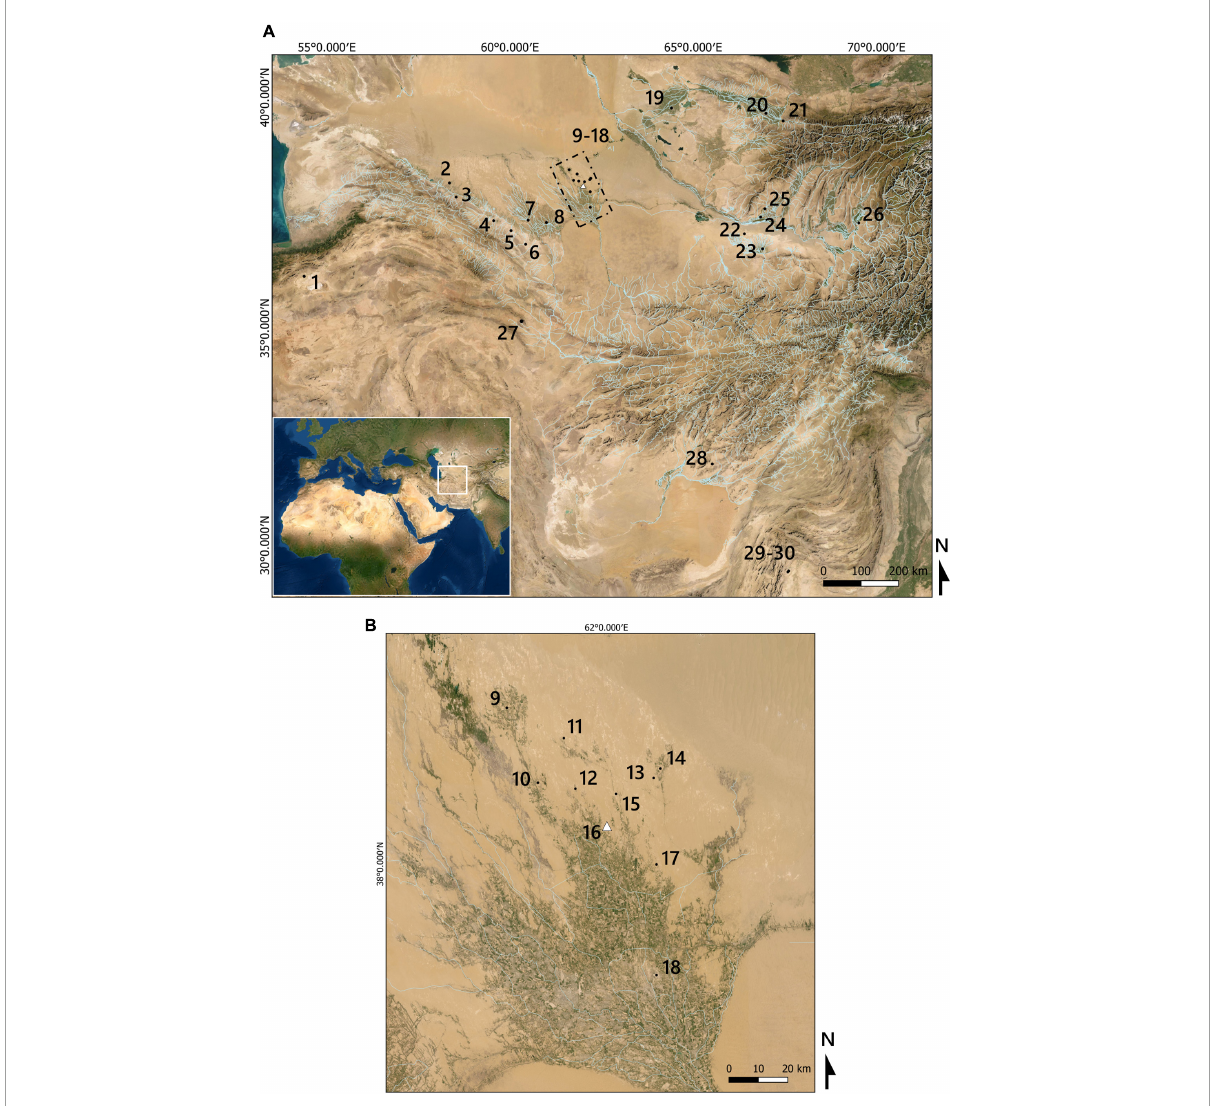
FIGURE1 (A) Map of southern Central Asia and surrounding areas with key ancient cities/areas: 1-Hissar, 2-Djeitun, 3-Anau, 4-Namagza-depe, 5-Ulug-depe, 6-Altyn-depe, 7-Tedjen Alluvial Fan, 8-Geoksyur Oasis, 9–18-Murghab Alluvial Fan, 19-Bukhara, 20-Samarkand, 21-Sarazm, 22-Dashly, 23-Balkh, 24-Sapalli-tepe, 25-Djarkutan, 26-Shortugai, 27-Shahr-i Sokhta, 28-Mundigak, 29–30-Mehrgarh and Nausharo; (B) Close up of Murghab Alluvial Fan highlighting important sites: 9-Kelleli sites, 10-Taip sites, 11-Egri Bogaz sites, 12-Adji Kui sites, 13-Ojakly, 14-Auchin sites, 15-Gonur depe, 16-Togolok 1, 17-Chopantam, and 18-Merv. Map created with QGIS using Esri World Imagery Basemap, Sources: Esri, DigitalGlobe, GeoEye, i-cubed, USDA FSA, USGS, AEX, Getmapping, Aerogrid, IGN, IGP, swisstopo, and the GIS User Community; and river dataset source: 2005@Savitsky Ivan (taken from https://www.caee.utexas.edu/prof/mckinney/Central_Asia_Data/index.htm)